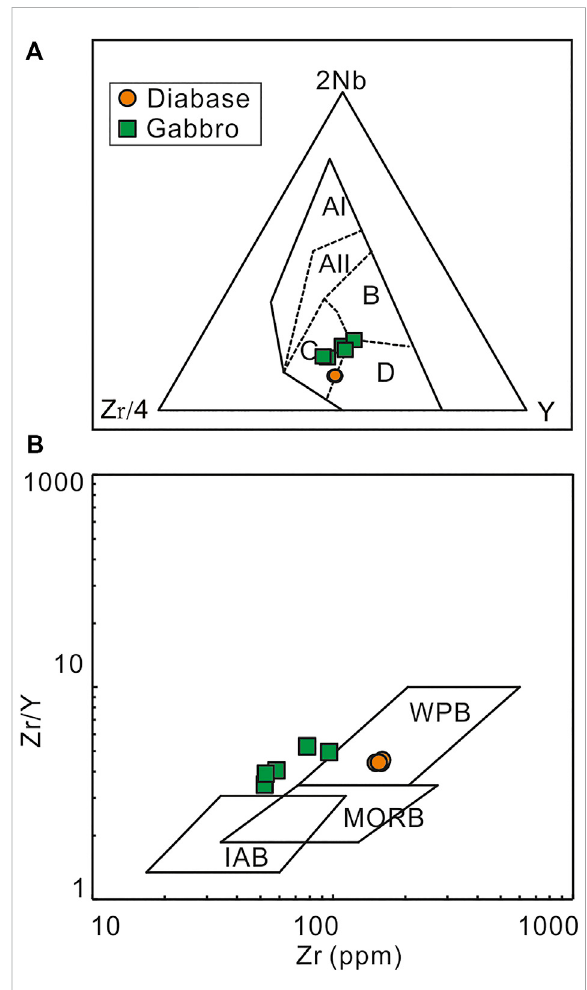
FIGURE 13 Tectonic environment discrimination diagrams for the diabase and gabbro: (A) 2Nb – Zr/4 – Y (Meschede, 1986); (B) Zr/Y versus Zr (Pearce & Norry, 1979). MORB – mid-ocean ridge basalts; IAB – island-arc basalts; WPB – within plate basalts; AI – within plate alkaline basalts; AII – tholeiite and within plate tholeiite; B – mid-ocean ridge basalts; C – within plate basalts and volcanic arc basalts; D – volcanic arc basalts and normal mid-ocean ridge